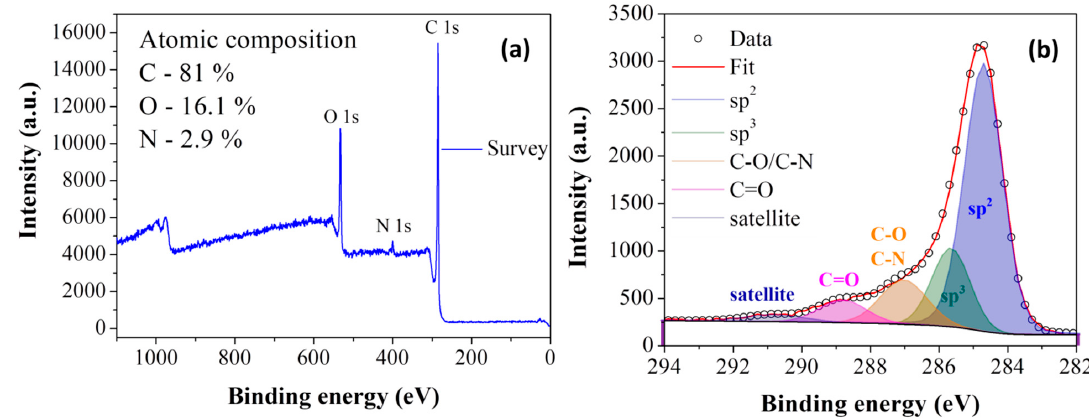
Figure 5. ( a ) XPS survey spectrum of the carbon sample with the respective atomic composition. ( b ) High-resolution XPS C1s envelope with assigned deconvoluted components. C 2020 , 6 , x FOR PEER REVIEW